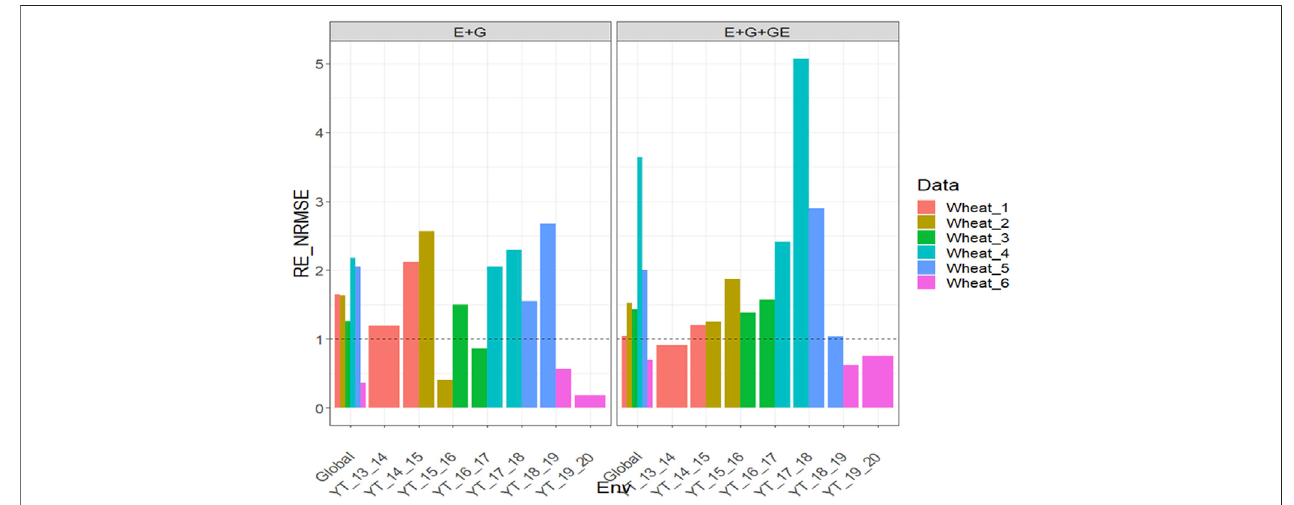
FIGURE 7 | Relative ef fi ciency in terms of normalized root mean square error (RE_NRMSE) computed by dividing the NRMSE under the best linear unbiased predictor model (GBLUP) between the NRMSE of the partial least squares regression method. Prediction performance is reported for each environment and across environments (Global) in datasets 7-12 (Wheat_1 to Wheat_6), also with two predictors (E + G and E + G + GE). When the RE_NRMSE > 1, the PLS outperforms the GBLUP method in terms of prediction performance (lower NRMSE).